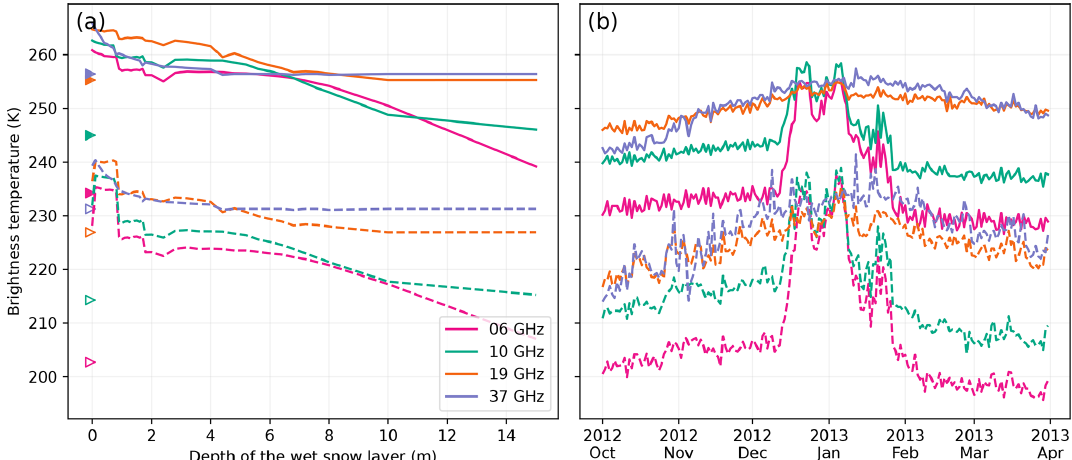
Figure 14. Brightness temperature as a function of the depth of the 10cm thick wet snow layer at Halvfarryggen at V-pol (solid curves) and H-pol (dashed curves) (a) . Values of dry brightness temperatures are marked by triangles. Each curve is the average of the 1000 best snowpacks. Time series of brightness temperature observations at Halvfarryggen (b)